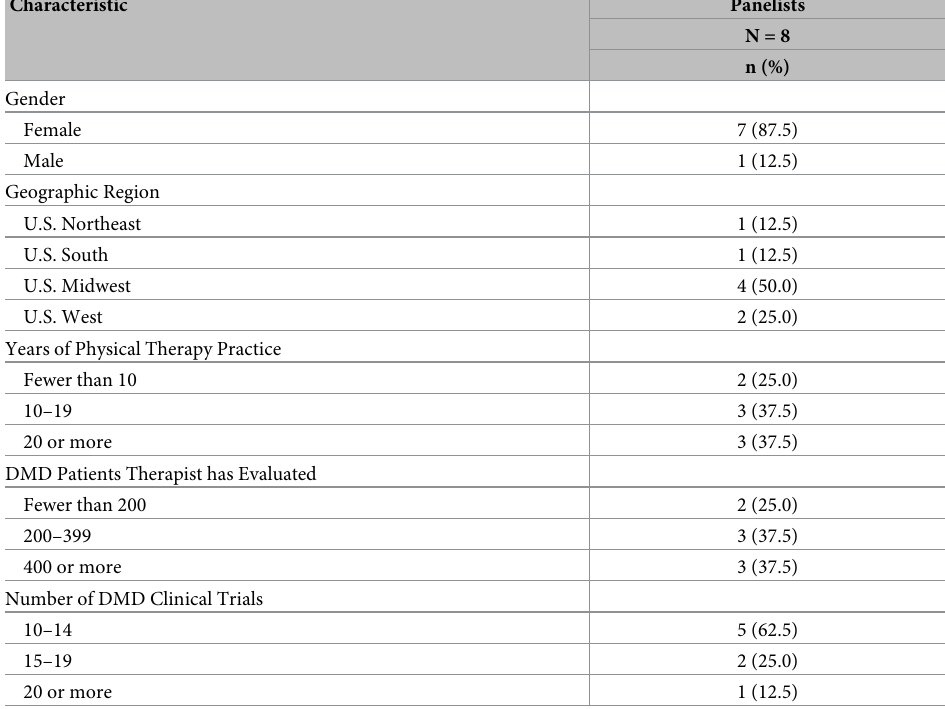
Table 1. Characteristics of physical therapists in